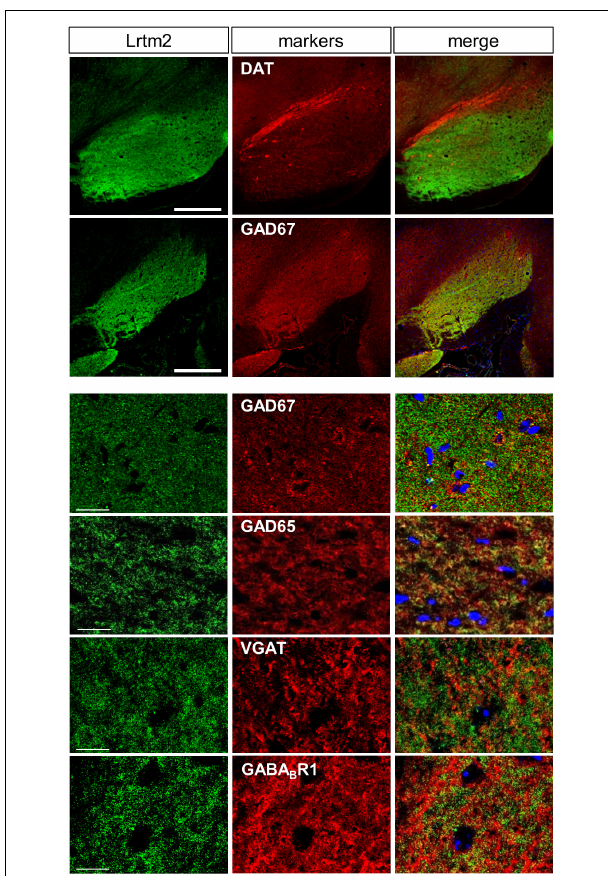
FIGURE 4 | Distribution of Lrtm2 in SNr. All pictures derive from double immunostaining of SNr in parasagittal sections with Lrtm2 ( green ) and indicated markers ( red ). Lrtm2 and GAD67 are colocalized except for local inhibitory neurons in which the cell body is marked with strong GAD67 signals surrounding the nuclei ( blue , DAPI), as seen in panels with higher magnification. Scale bars , 500- µ m-thick; 20- µ m-thin.